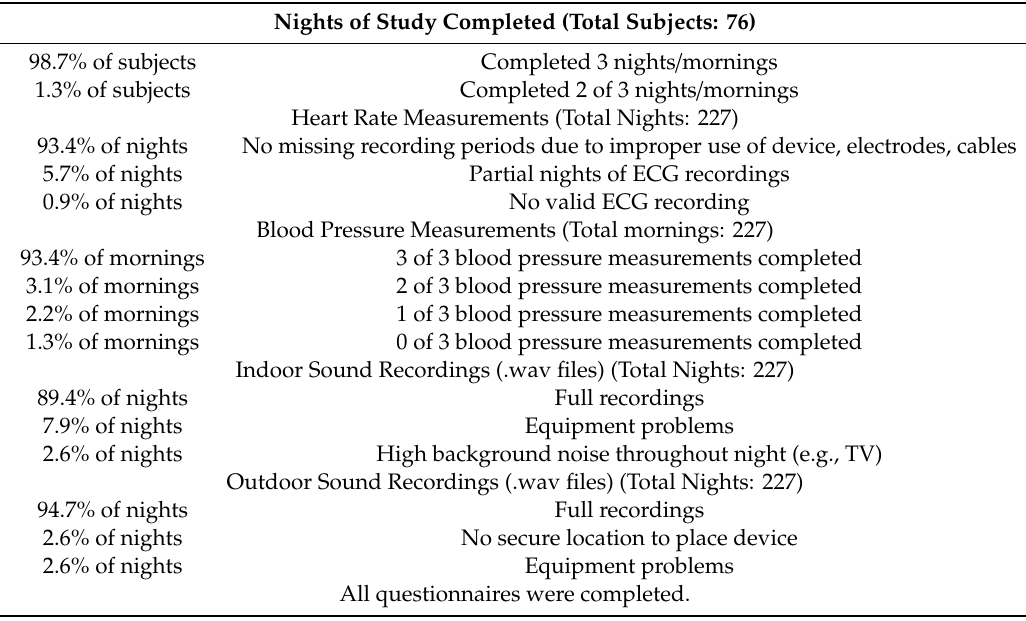
Table 3. Overview of data quality.